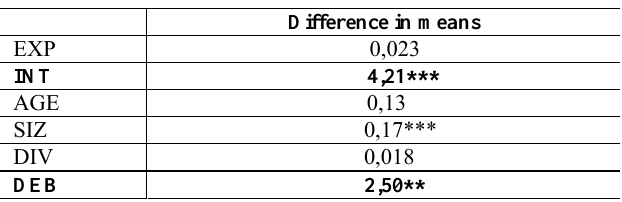
Table 8: Test of equality of means between family and non-family